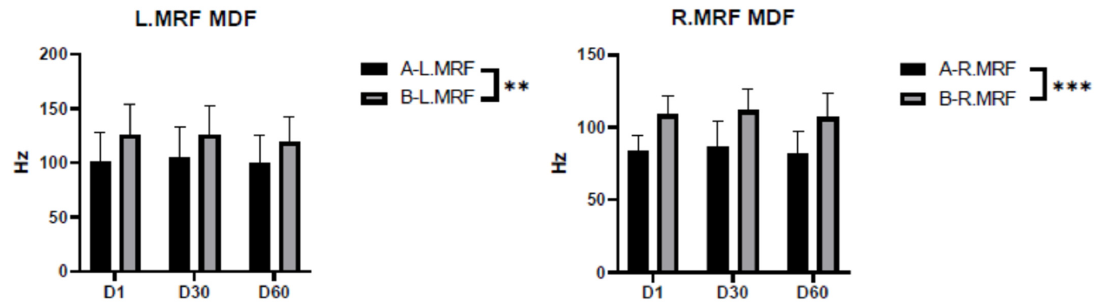
and while wearing sports shoes. Note: ** indicates p < 0.01, which is highly significant; *** indicates